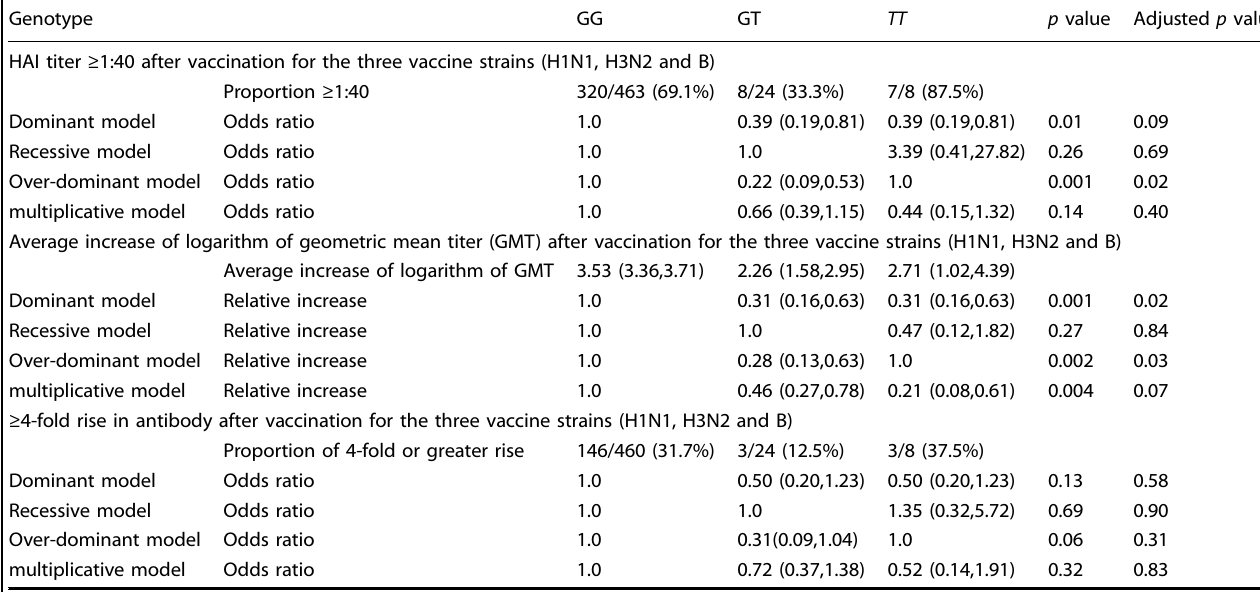
Table 1. Relationship between host SNPs in TLR7 (rs5741880) and vaccine response. Genotype GG GT TT p value Adjusted p value HAI titer ≥ 1:40 after vaccination for the three vaccine strains (H1N1, H3N2 and